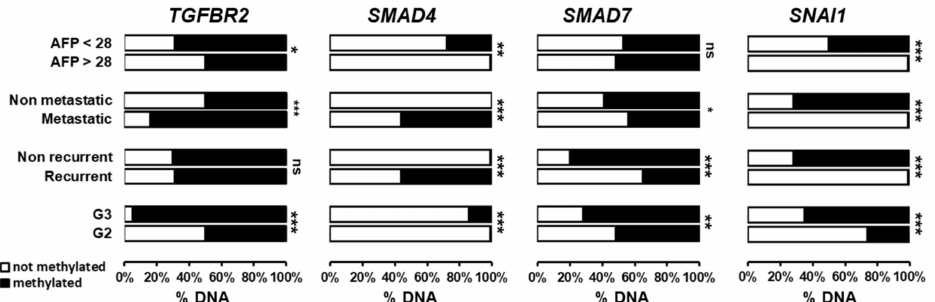
Figure 6. Methylation status of the promoter of TGFBR2 , SMAD4 , SMAD7 and SNAI1 genes in human HCC tumors and correlation with clinical and biological parameters. The percentage of DNA methylation was correlated with tumor grade (G2 vs. G3), recurrence, metastasis and serum alfa-fetoprotein levels. *** p < 0.001; ** p < 0.01; * p < 0.05; ns p >